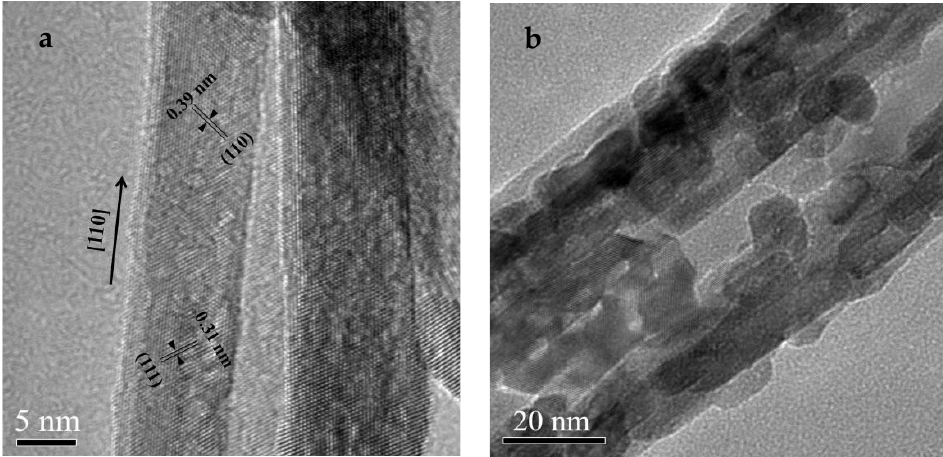
Figure 6. HRTEM images of CeO 2 -R ( a ) and CeO 2 -T ( b ).